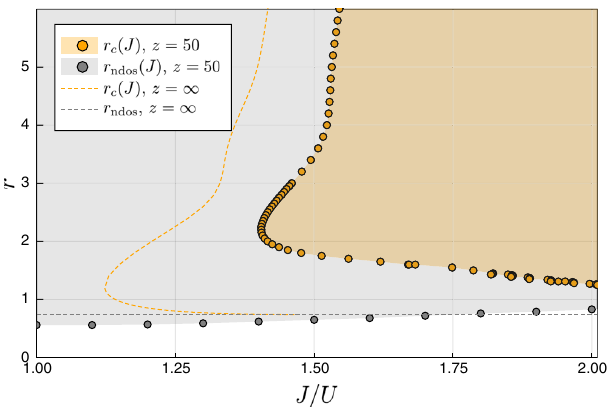
FIG. 11. Phase diagram in the pump versus hopping plane obtained by DMFT NCA for z ¼ 50 (yellow points) and Gutzwiller mean-field theory ( z ¼ ∞ , yellow dashed line). We further plot the thresholds for NDOS obtained within the two approaches. We see that fluctuations due to finite connectivity reduce the broken symmetry phase, pushing it toward higher values of hopping and drive. We interpret this effect as a signature of hopping-induced losses, which reduce the local gain and prevent the system from becoming unstable at finite frequency. 10 Parameters: dim H ¼